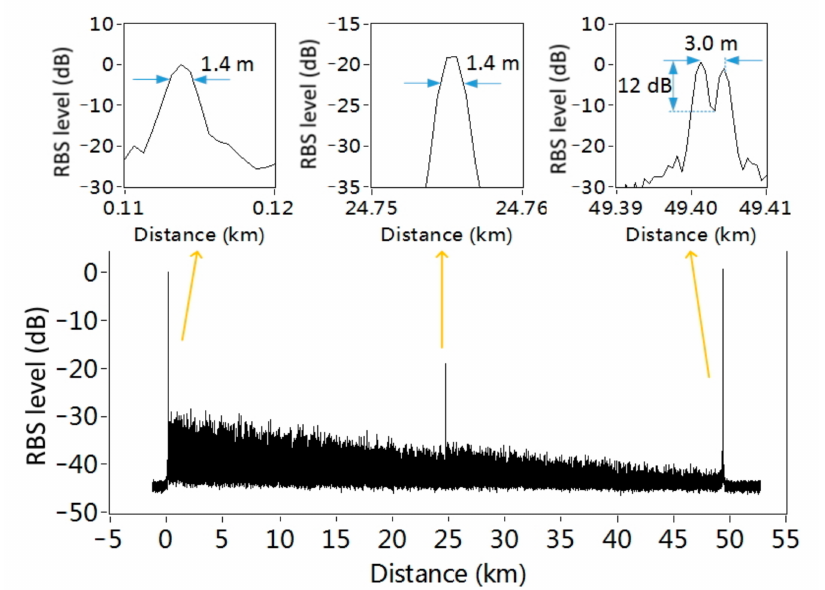
Figure 3. The normalized intensity of Rayleigh backscattering (RBS) as well as the reflection of connectors along the 50 km FUT after 100 averages. Insets: the reflection of connectors at the near, middle, and far end of the